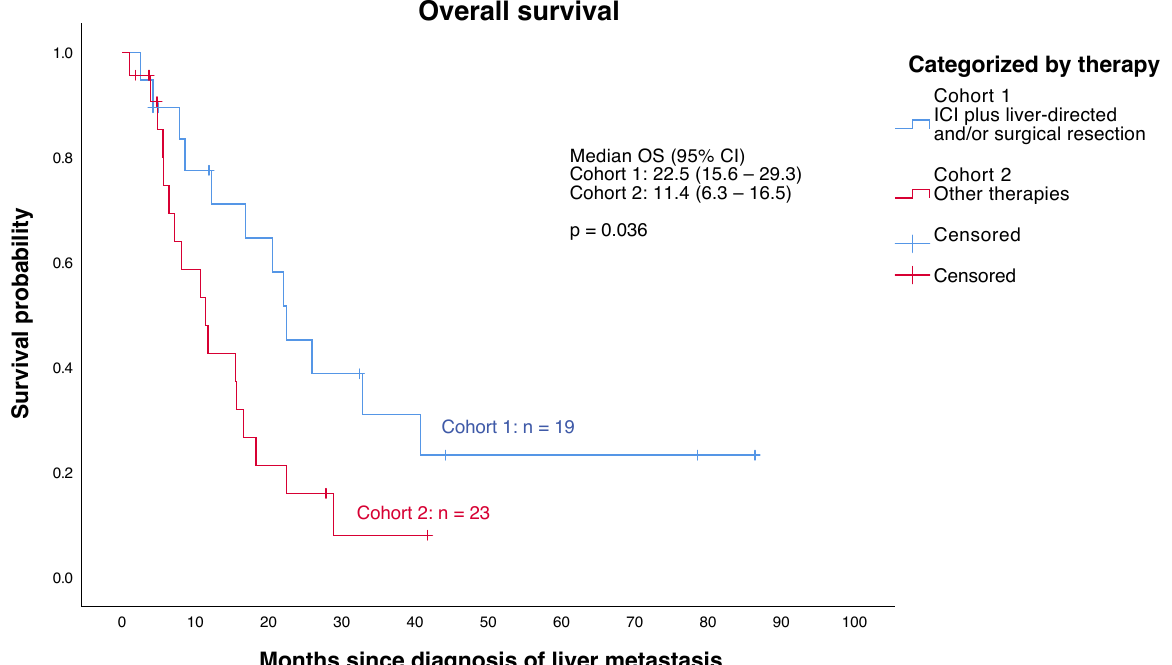
Figure 2. Kaplan–Meier estimates for overall survival (OS) from liver metastasis to death according to therapy. Note: Cohort 1 includes all patients treated with ICI plus liver-specific therapies (surgical resection of liver metastases and/or liver-directed therapies), which was compared to Cohort 2 including any other therapy regimens such as any monotherapies and any other combination regimens (Table